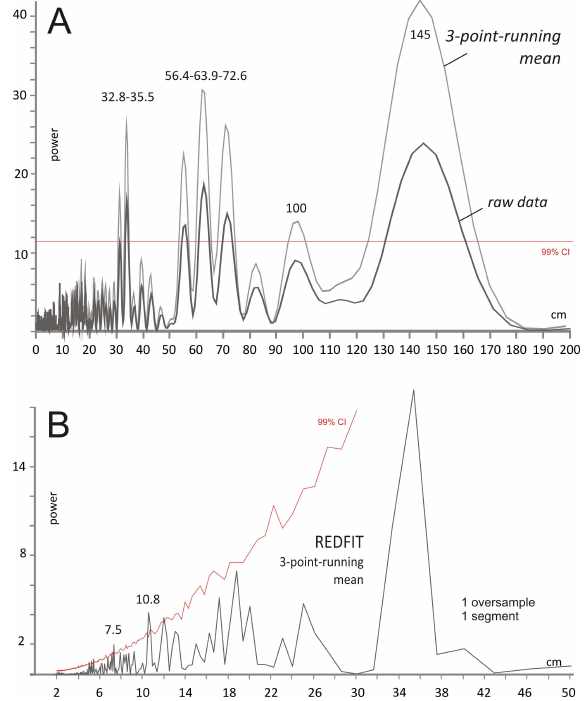
Fig. 3. Lomb–Scargle (a) and REDFIT (b) periodograms with indi- cation of the 99% confidence interval. Longer frequencies are bet- ter revealed in the power spectra, whilst short cyclicities are better supported by the